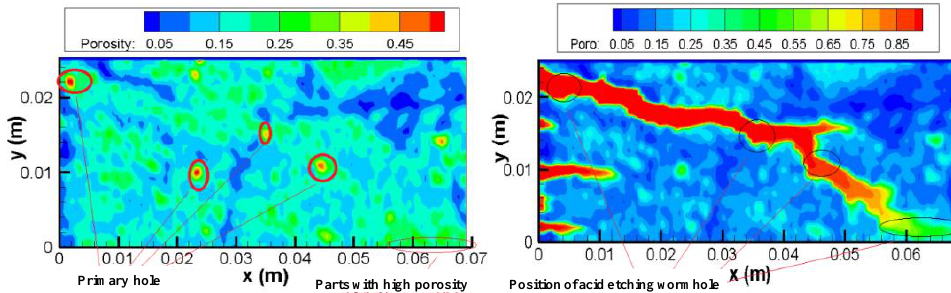
Figure 13. Effect of pore space distribution on the expansion of gelling acid wormhole.